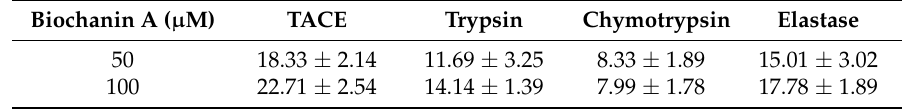
Table 1. α -Secretase (TACE), trypsin, chymotrypsin, and elastase inhibition (%) 1,2 of biochanin